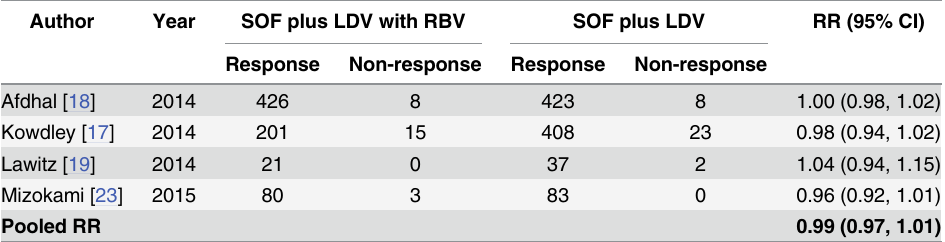
Table 5. Pooled risk ratio of sustained virological response at week 12 after the end of treatment between sofosbuvir plus ledipasvir with ribavirin and sofosbuvir plus